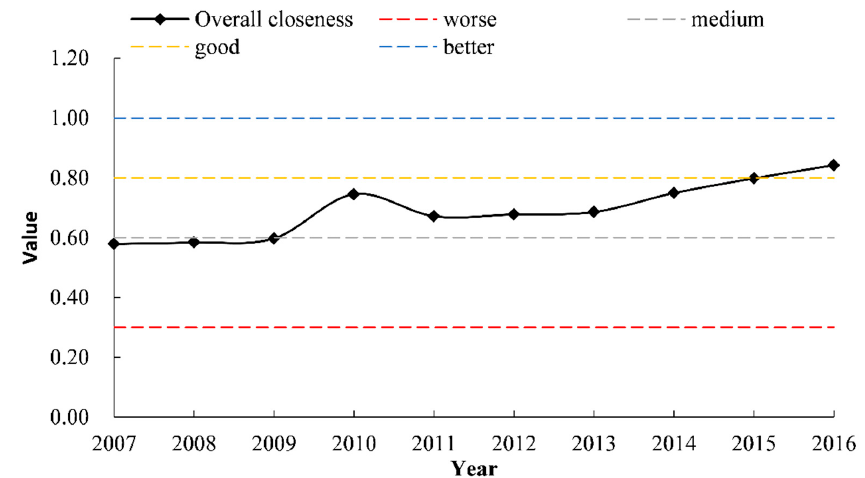
Figure 3. Trends in the overall performance.